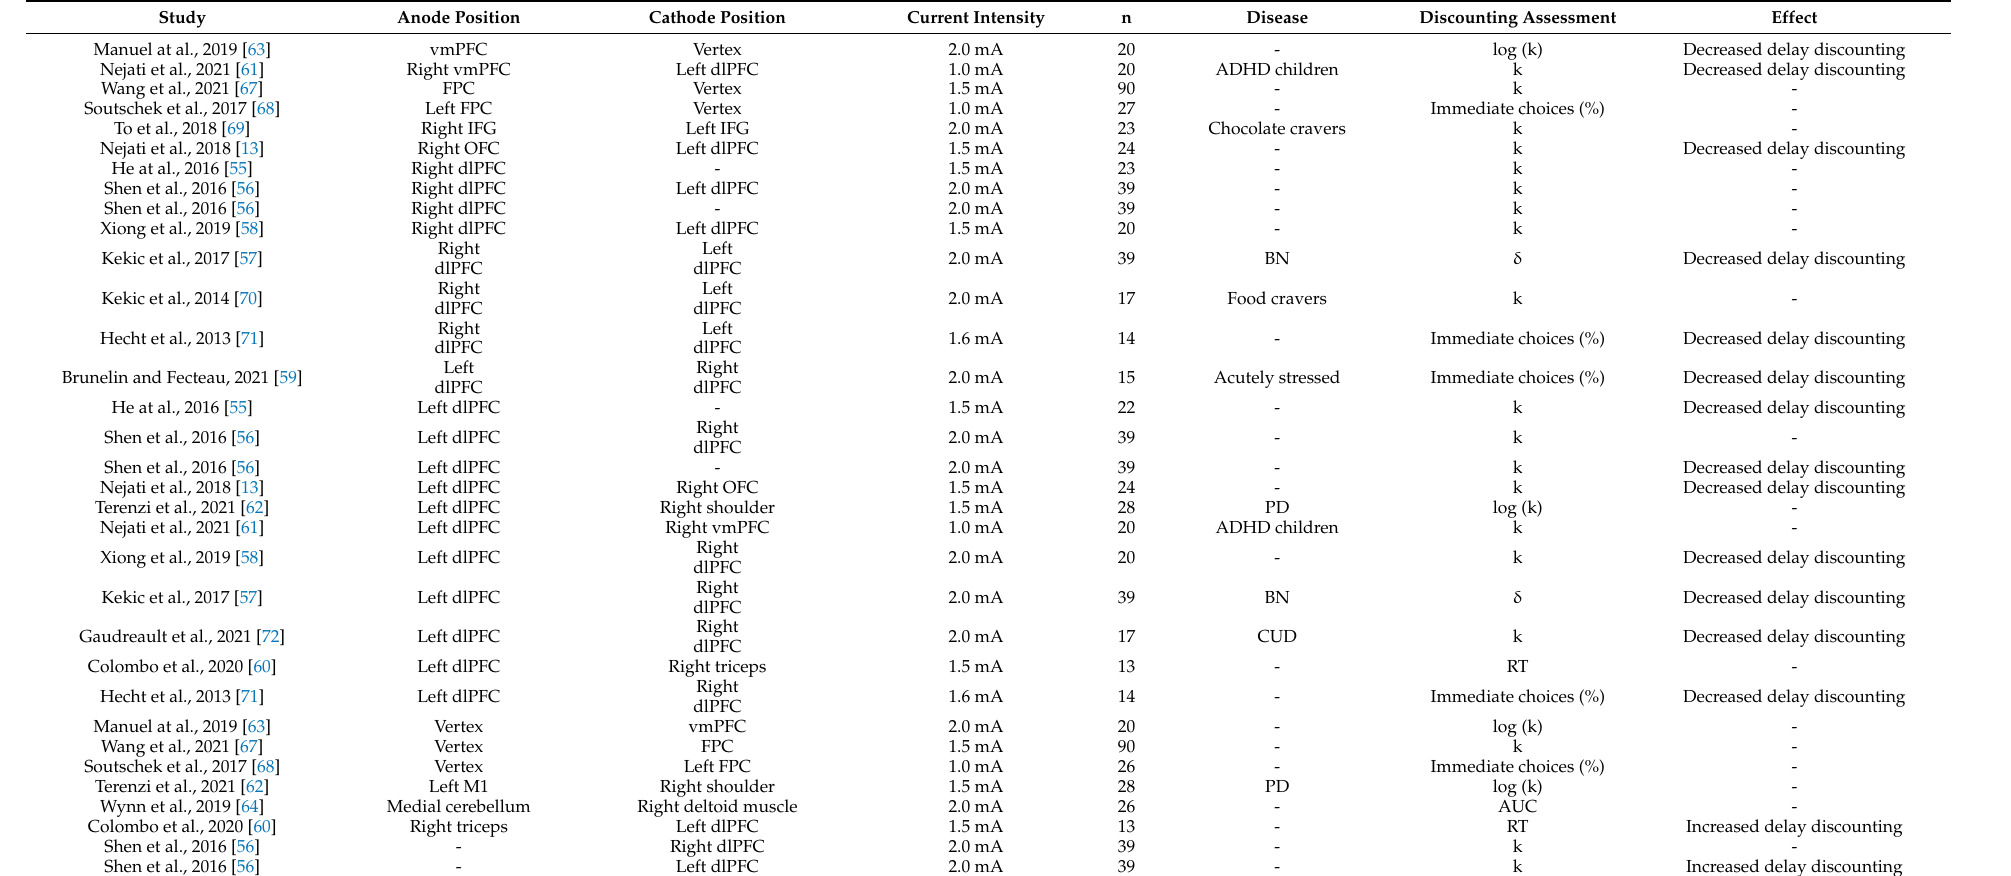
Table 2. Studies investigating delay discounting performance modulation by tDCS. PD = Parkinson’s disease; ADHD = attention deficit hyperactivity disorder; BN = bulimia nervosa; CUD = cocaine use